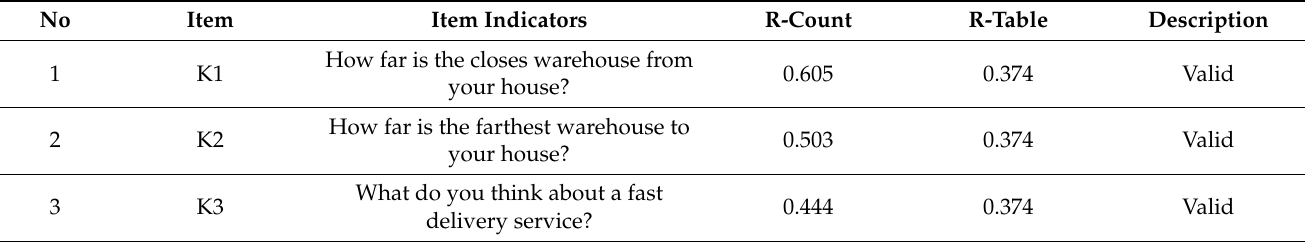
Table 3. Results of attribute-level validity